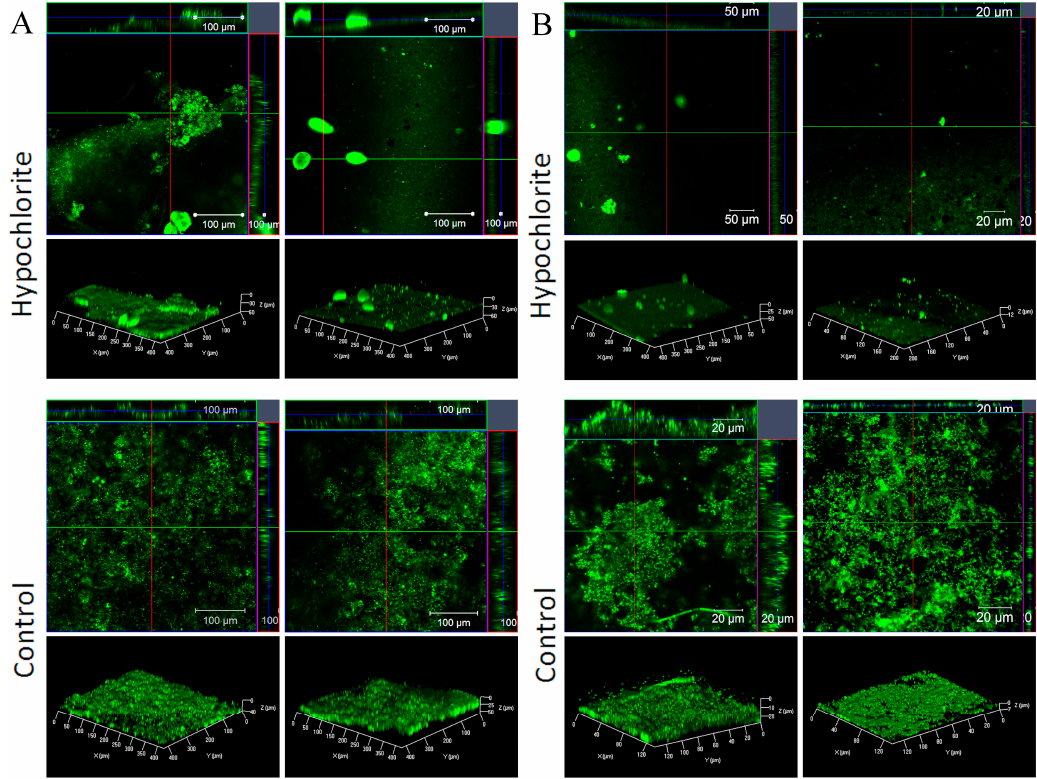
Figure 5. Confocal microscopy images of biofilm on the surface of BioCleanEco coated specimens. The biofilms were washed and stained with SYTO9, and Z-stacks of each were acquired by confocal laser scanning microscopy (CLSM). Upper panels, orthogonal projections of Z-stacks; bottom panels,